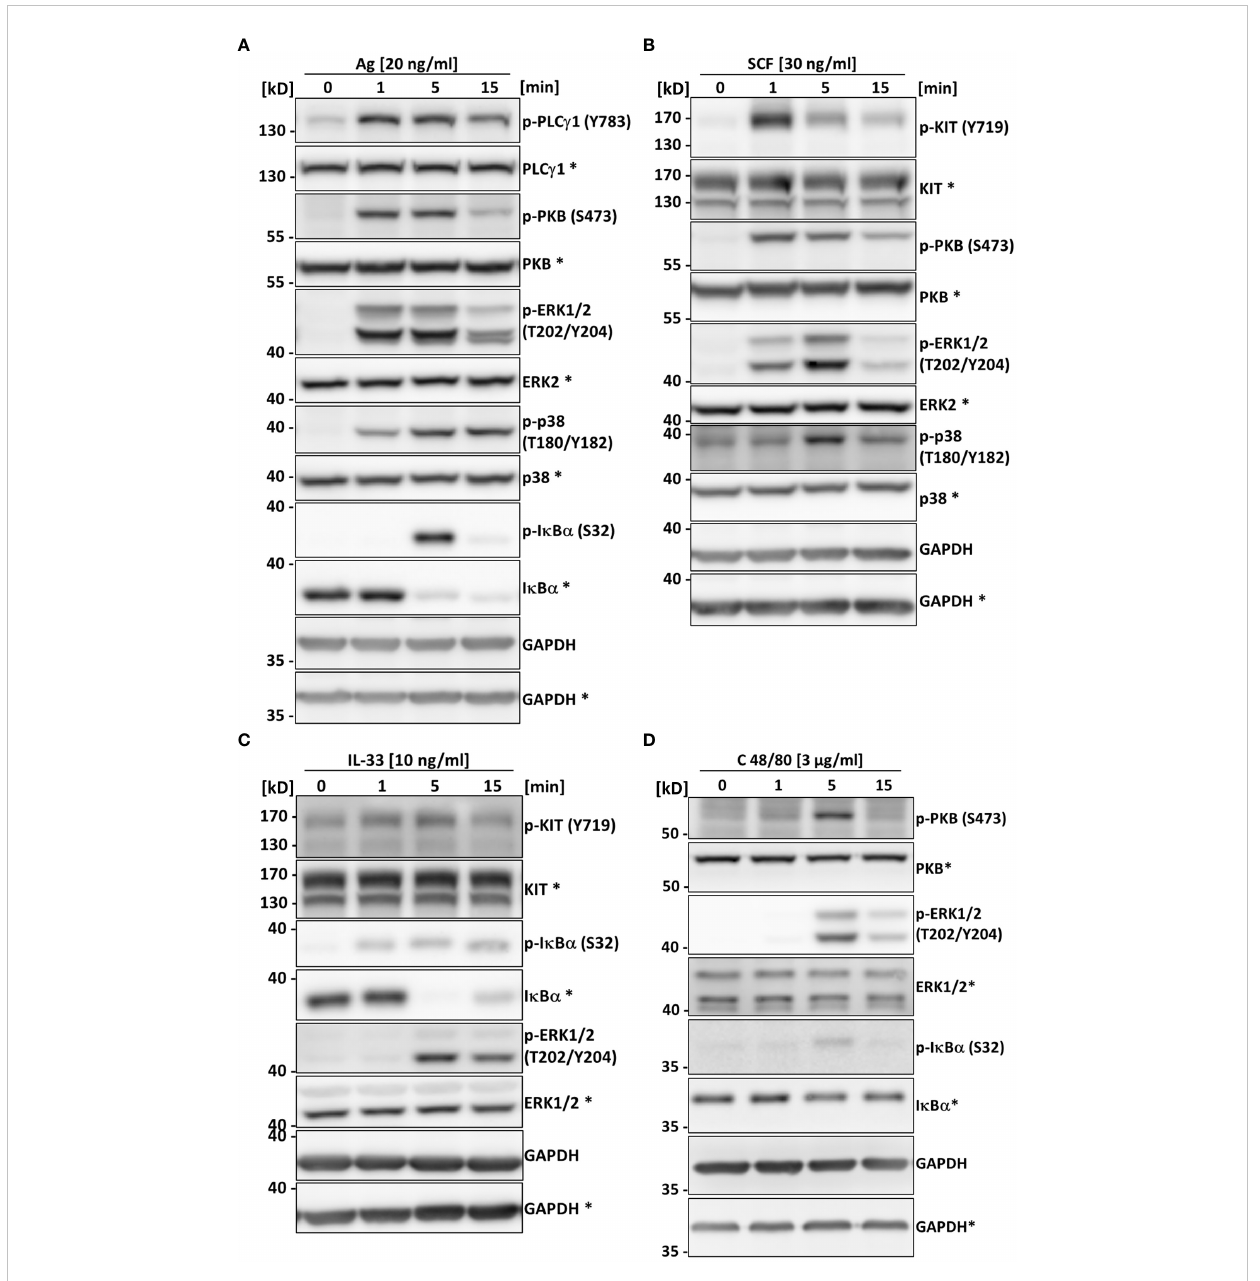
FIGURE 4 The PMC-306 cell line can be used to analyze signaling in response to Ag, SCF, IL-33 and C48/80. The activation of PLC g 1, PKB, the MAPKs ERK and p38, KIT and the NF k B pathway in response to Ag (20 ng/ml) (A) (n=3), SCF (30 ng/ml) (B) (n=3), IL-33 (10 ng/ml) (C) (n=3) or C48/80 (3 µg/ml) (D) (n=3) after 1, 5 and 15 minutes of stimulation was studied by Western blot analysis. Activation of the pathways was analyzed by phospho-speci fi c antibodies (p-PLC g 1 (Y783), p-KIT (Y719), p-PKB (S473), p-ERK1/2 (T202/Y204), p-p38 (T180/Y182), p-I k B a (S32) for key signaling proteins. For loading controls, antibodies recognizing the respective total proteins were used. Asterisks indicate detection on the same membrane. GAPDH served as control for equal loading of both gels. Representative experiments are depicted for each stimulation